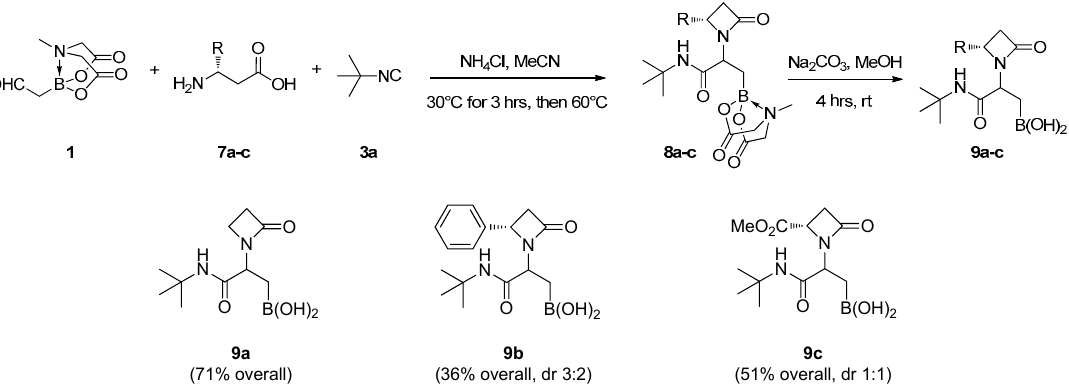
Figure 2. ( a ) Asymmetric unit of 6d . Thermal ellipsoids at RT were drawn at the 30% probability level. The same atom color code as in Figure 1 was employed. ( b ) Molecular structure of the S– 6d enantiomer (the R enantiomer is also present in the crystal in a 1:1 ratio)